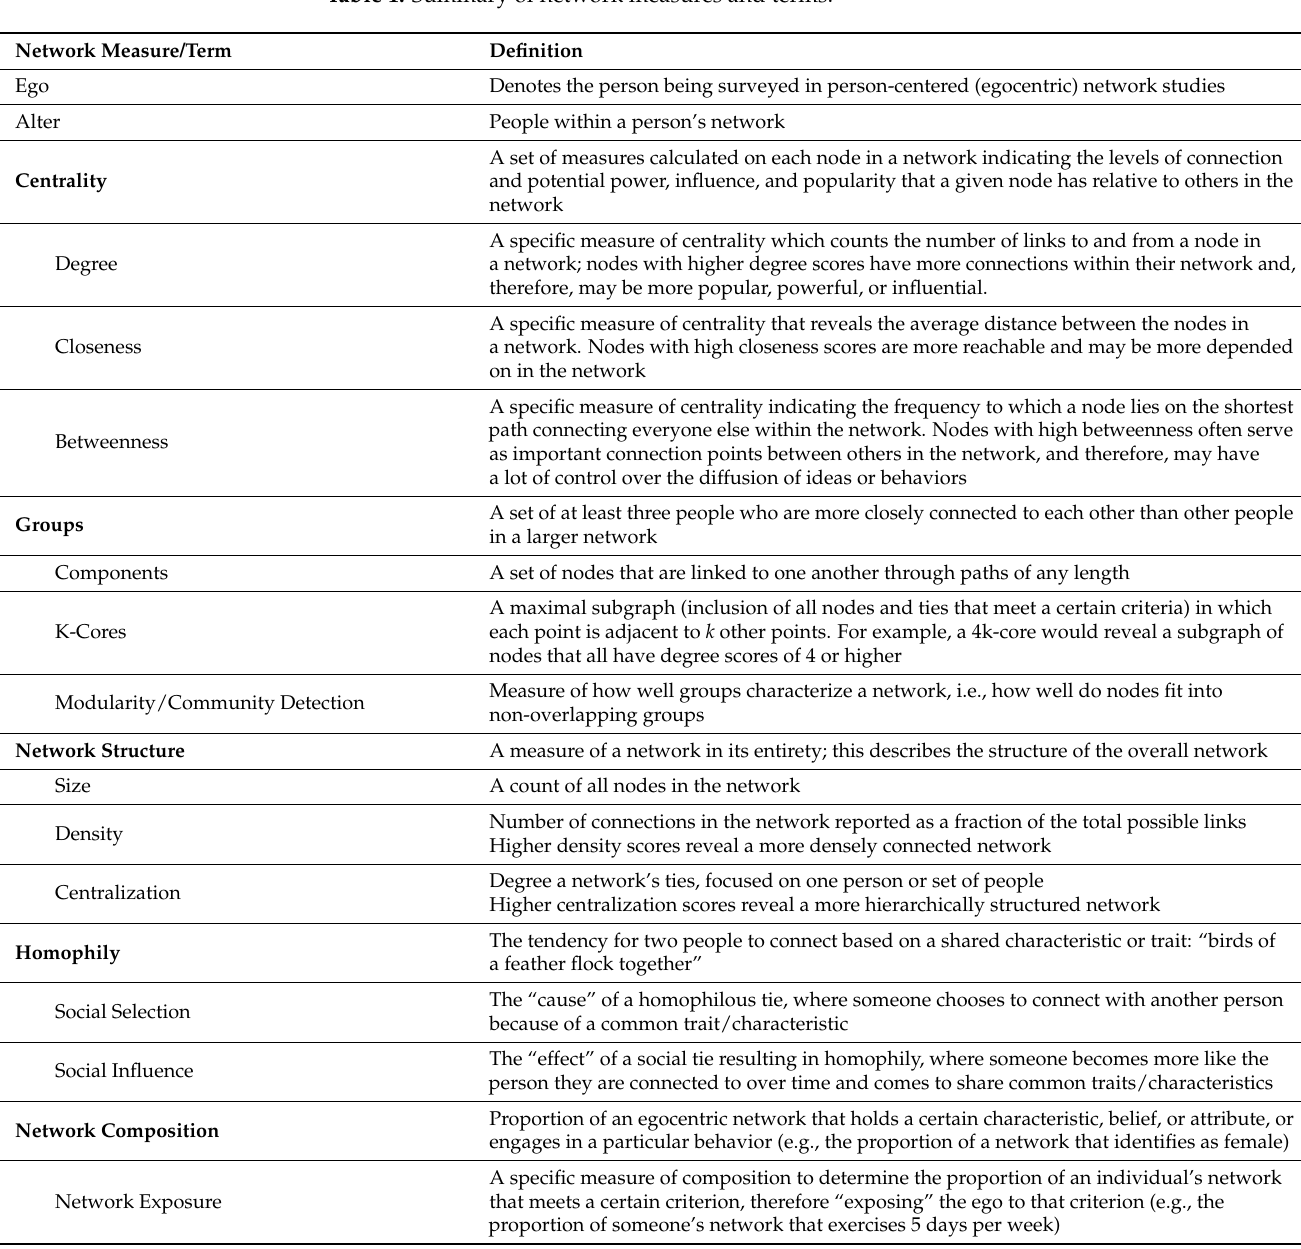
Table 1. Summary of network measures and